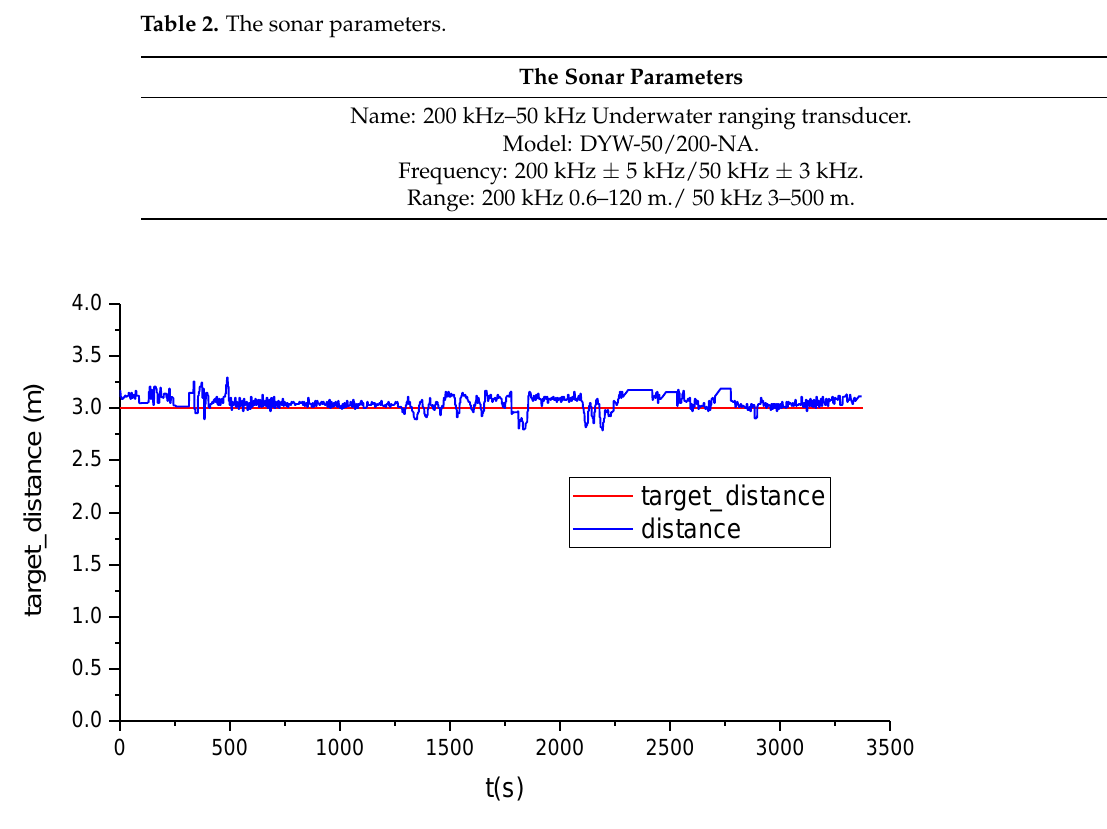
Figure 15. The AUV test results for wall tracking.